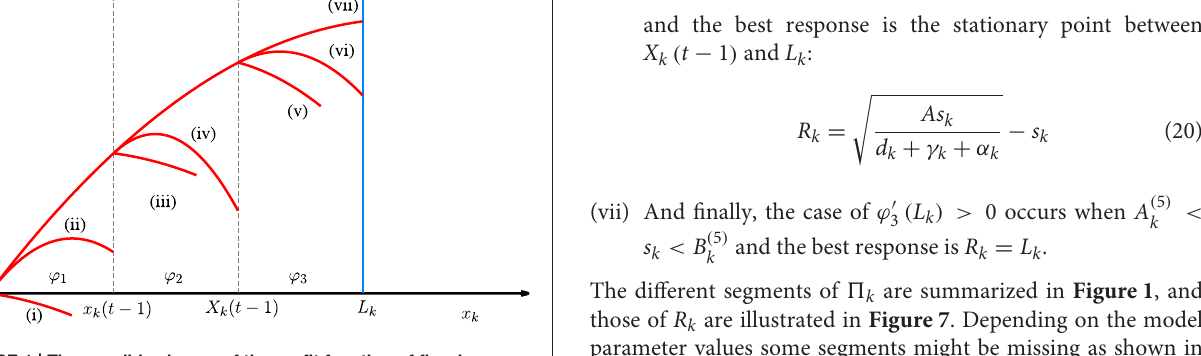
FIGURE 1 | The possible shapes of the profit function of firm k .